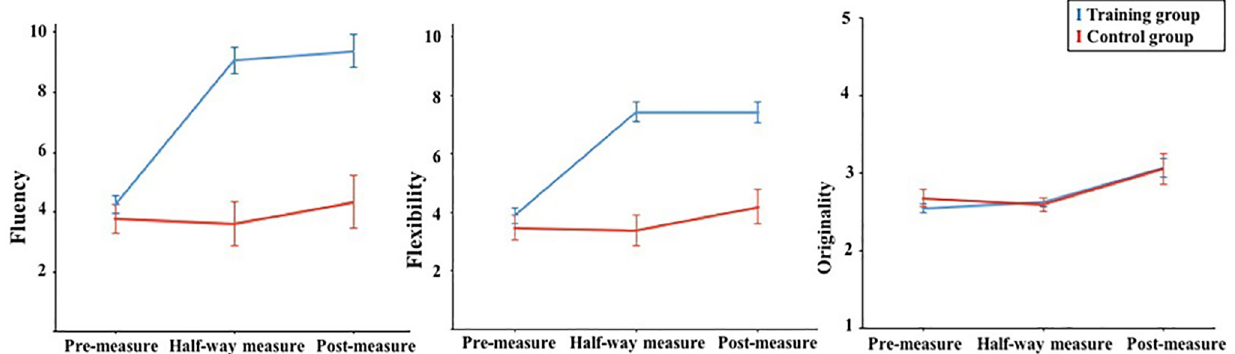
Fig 2. Effects of the creativity training on visual imagination task as function of treatment and measurement time.